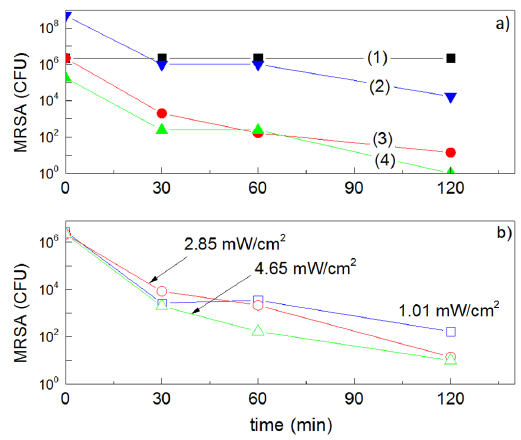
Figure 13. ( a ) Effect of the initial bacterial concentration of MRSA loss of viability on: (1) Unsputtered PES and by co ‐ sputtered TiO 2 /Cu ‐ PES for 3 min tested in the dark: (2) 10 8 CFU/mL, (3) 10 6 CFU/mL and (4) 10 5 CFU/mL. ( b ) Effect of light intensity on MRSA loss of viability on co ‐ sputtered TiO 2 /Cu ‐ PES for 3 min under: 1.01, 2.85, and 4.65 mW/cm 2 . The relevance of TiO 2 ‐ Cu catalysts and photocatalysts addressing the issue of bacterial inactivation is reflected in the increasing number of studies focusing on the antibacterial effects of TiO 2 ‐ Cu and TiO 2 /Cu in the form of 2D ‐ coatings, suspensions, spheres, alloys, and decorated binary oxides [175–181].